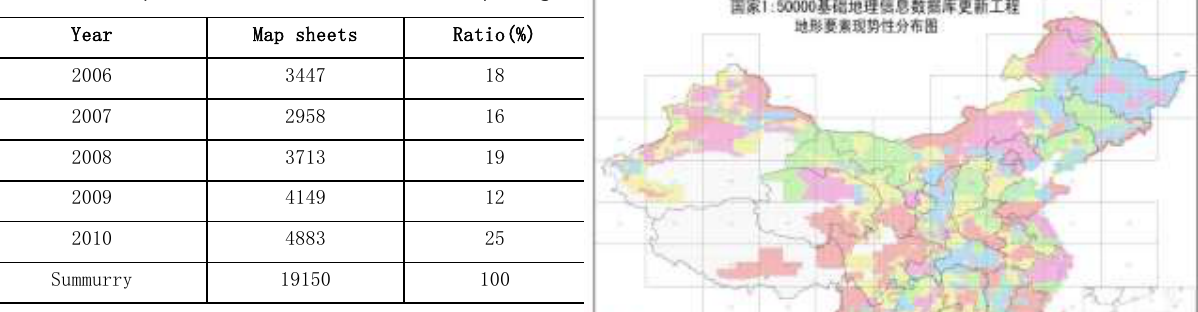
Table.3 The up-to-dateness of 1:50000 DLG after updating